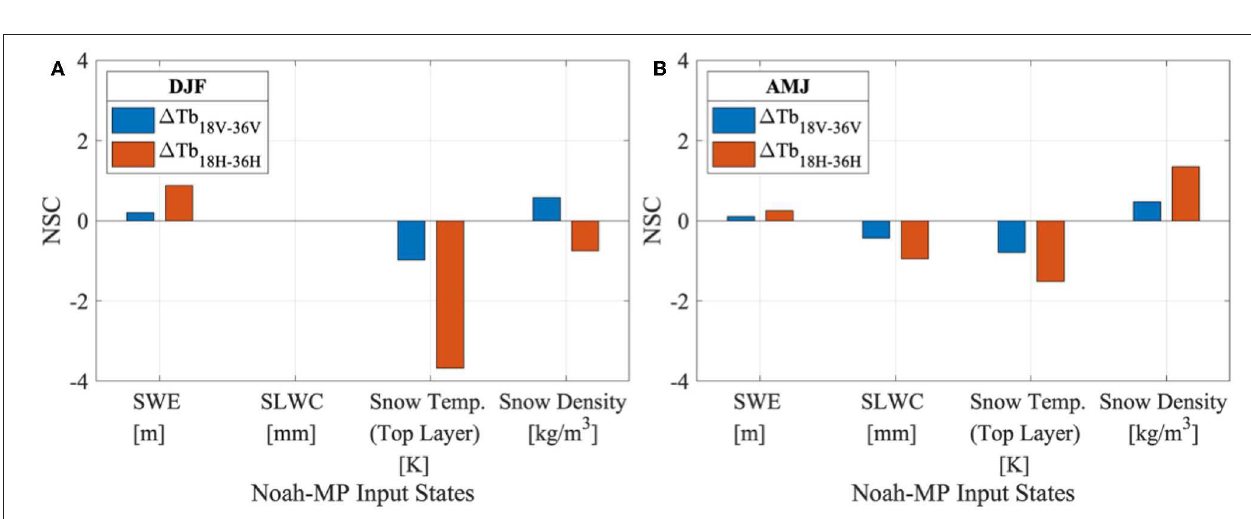
signs for SWE observed in Figures 6 , 7 often result from cases like these. This is a useful reminder that statistical methods can give the correct answer but not always for the proper